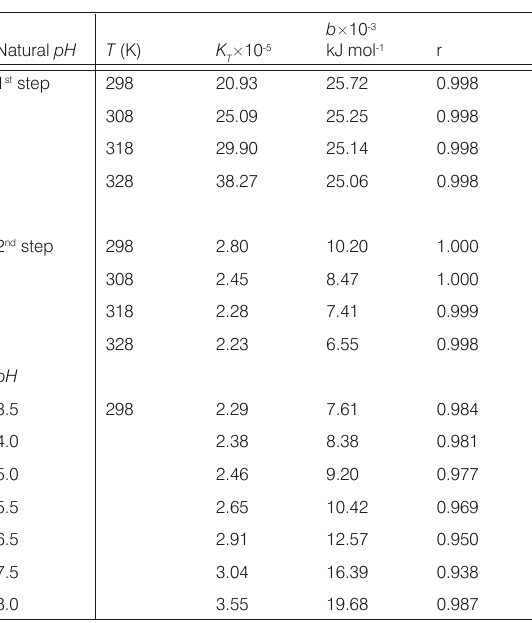
Table 3. The Langmuir isotherm parameters for MCPA adsorption on the BS.